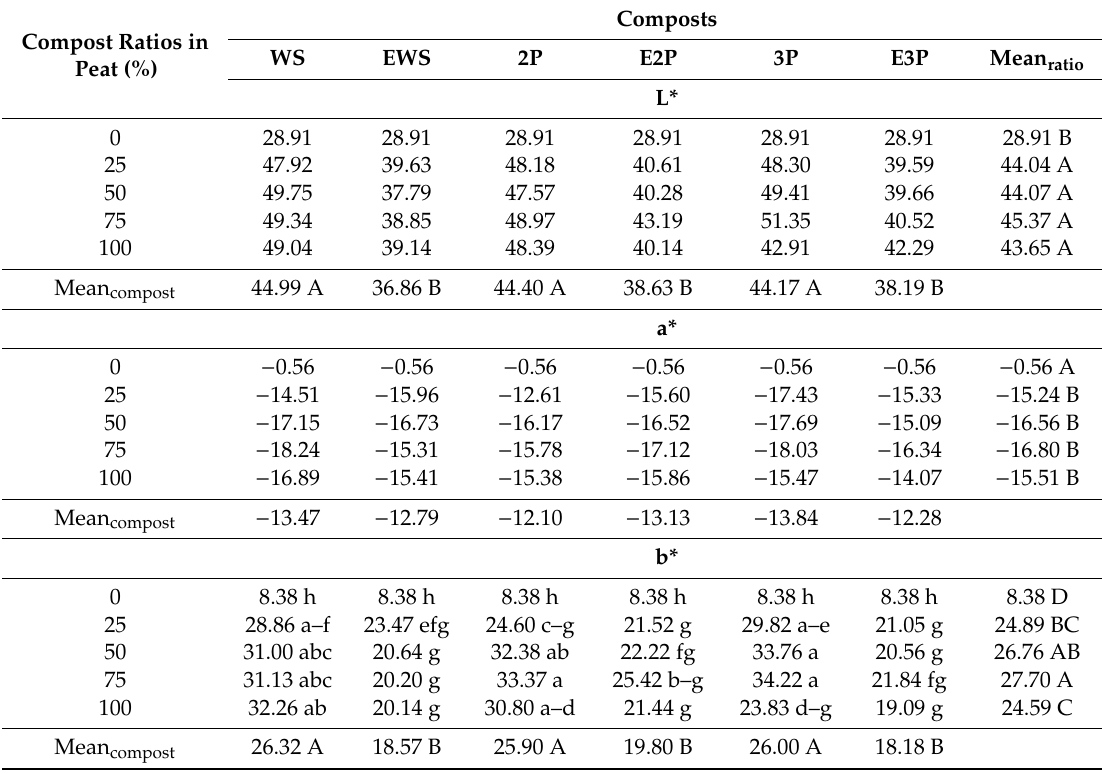
Table 8. E ff ects of treatments on leaf